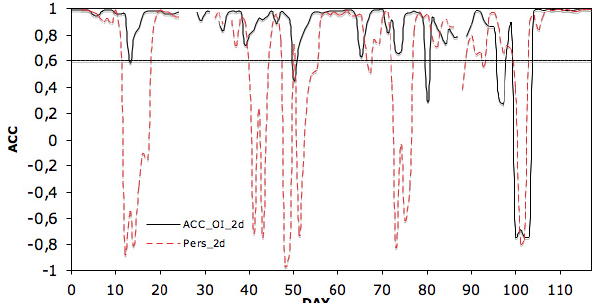
Fig. 9. Mean temperature ACC computed respect to OI analyses for RAMS second-day forecast (black solid line) and for the second day of a 48-h persistence forecast (dashed line) based on OI analyses. Days 0–24 are June, days 25–55 are July, days 56–86 are August and days 87–116 are September. RAMS forecasts and analyses are not available for five days (gaps in the solid and dashed lines at the beginning of July and